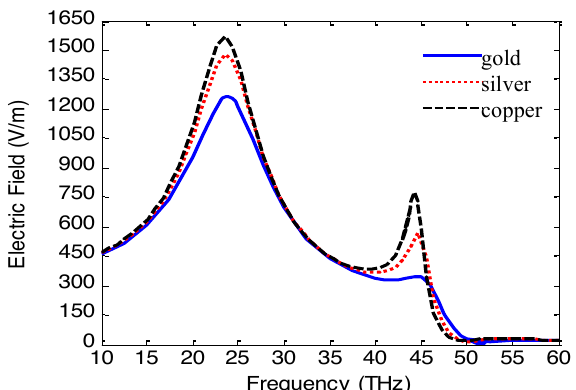
Figure 6 a. The electric field variation versus frequency for Figure 4. The electric field variation versus frequency for cylindrical dipole with different values of cylindrical radius, rhombic dipole IR-nanoantenna made from different metals b. The electric field variation versus frequency for printed on a dielectric substrate with h=150 nm, w=5 µm, cylindrical dipole with h=150 nm, w=5 µm, L=9 µm, t=50 L=9 µm, t=50 nm, L =2.2 µm, gap=100 nm and ψ =20 o . nm, r=1.2 µm for different values of gap. s